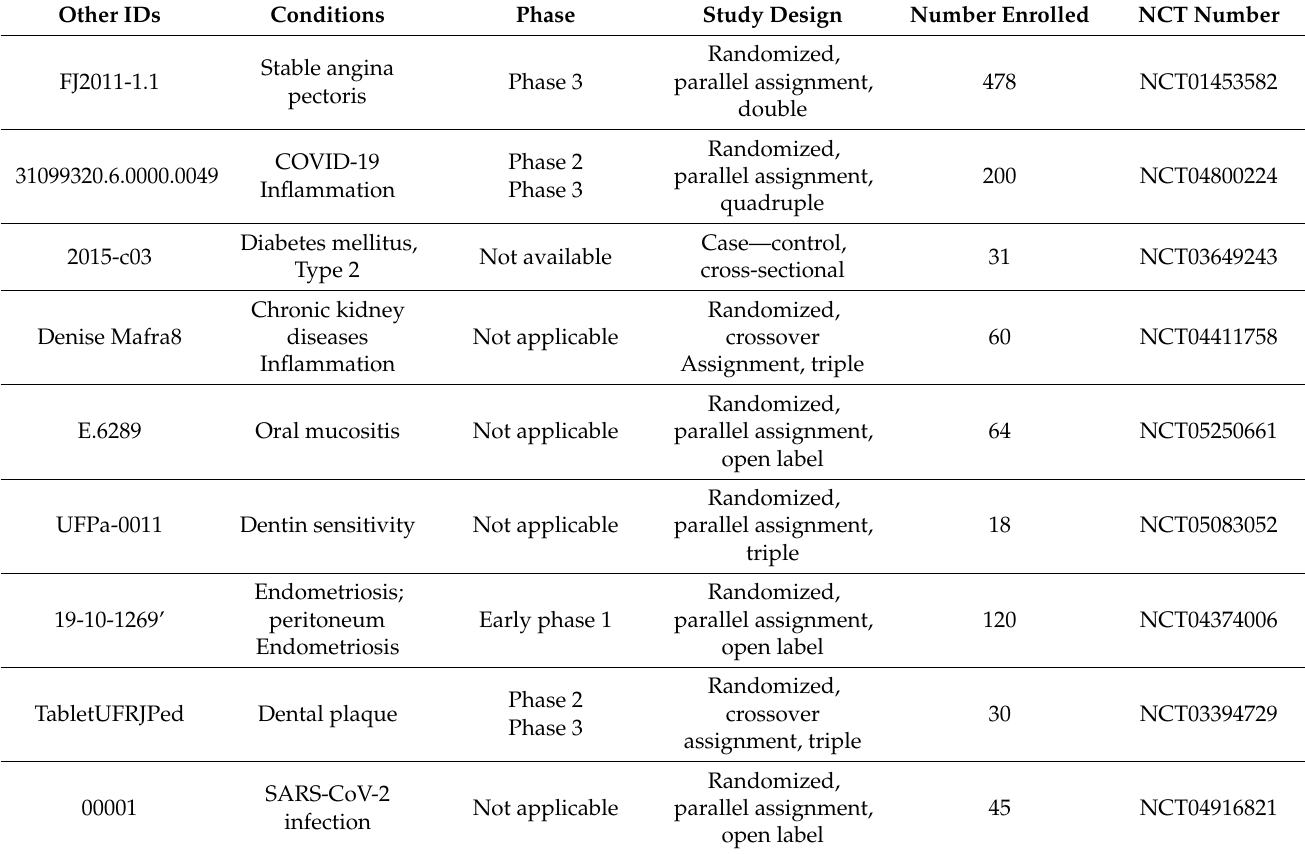
Table 8. Various clinical trials have been conducted to ensure the efficacy of propolis against various